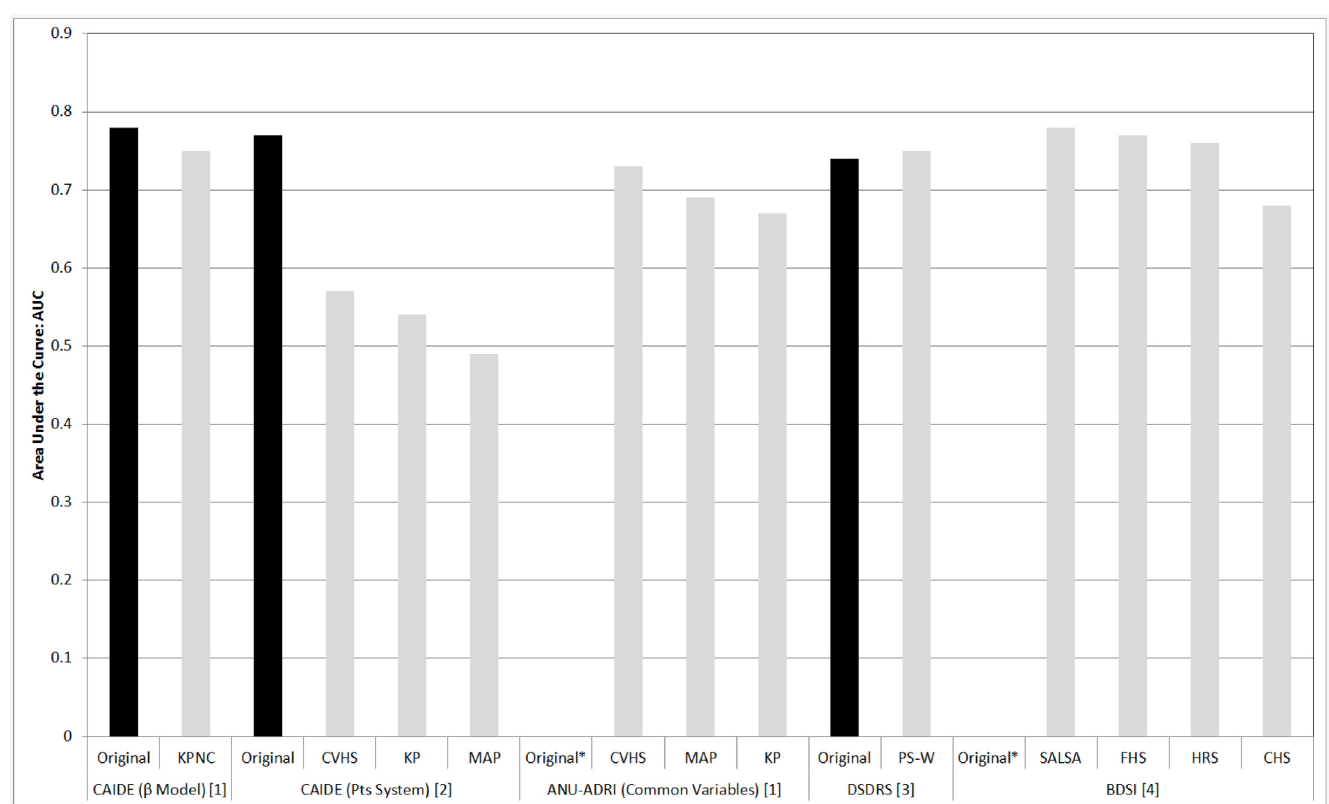
Fig 2. Comparison of AUC indices in development vs. validation cohorts across different dementia risk prediction models. Key: BDSI, Brief Dementia Screening Index; CAIDE, Cardiovascualr Risk Factors, Aging and Dementia; CHS, Cardiovascular Health Study; CVHS, Cardiovascular Health Cognition Study; DSDRS, Type-2 Diabetes Specific Dementia Risk Score; FHS, Framingham Heart Study; KP, Kungsholmen Project; KPNC, Kaiser Permanente Medical Care Program of Northern California; MAP, Rush Memory and Aging Project; PS-W, Pathways study cohort from Washington; Pts, Points; SALSA Sacramento Area Latino Study on Aging. References [1] Anstey KJ, Cherbuin N, Herath PM, Qiu C, Kuller LH, Lopez OL, et al. A Self-Report Risk Index to Predict Occurrence of Dementia in Three Independent Cohorts of Older Adults: The ANU-ADRI. PLoS One. 2014;9(1):e86141; [2] Exalto LG QC, Barnes D, Kivipelto M, Biessels GJ, Whitmer RA. Midlife risk score for the prediction of dementia four decades later. Alzheimers Dementia. 2013; [3] Exalto LG, Biessels GJ, Karter AJ, Huang ES, Katon WJ, Minkoff JR, et al. Risk score for prediction of 10 year dementia risk in individuals with type 2 diabetes: a cohort study. The Lancet Diabetes and Endocrinology. 2013; [4] Barnes DE, Beiser AS, Lee A, Langa KM, Koyama A, Preis SR, et al. Development and validation of a brief dementia screening indicator for primary care. Alzheimers Dementia. 2014:S1552-5260. Notes * No development dataset. Rather, model tested in different